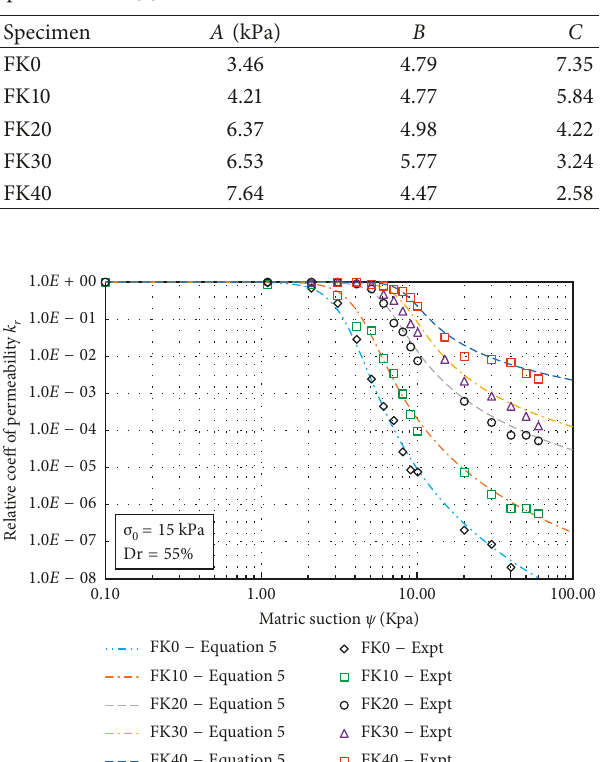
Table 6: Parameters A , B , and C for permeability function of soil specimens for (5).